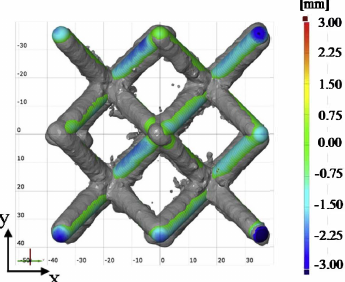
Figure 6. Top view of lattice structure. Reprinted from Ref. [15].